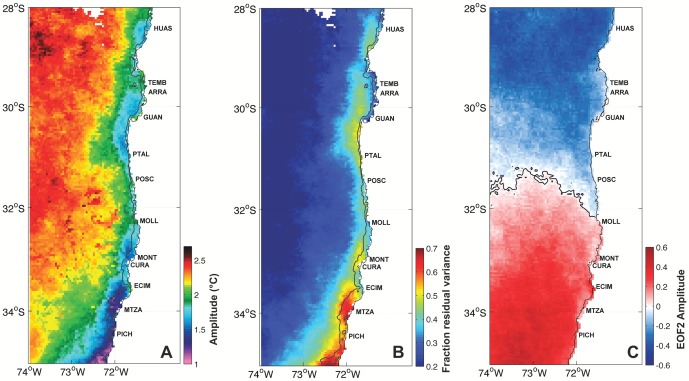
Spatial pattern in SST variability derived from harmonic analysis (A, B) and EOF analysis (C) of MODIS-Aqua imagery for 2003–2013.(A) Amplitude of the seasonal cycle. (B) Residual variance, i.e. not explained by the seasonal cycle. (C) Spatial pattern of the second mode of variability from the EOF analysis of weekly SST composites.